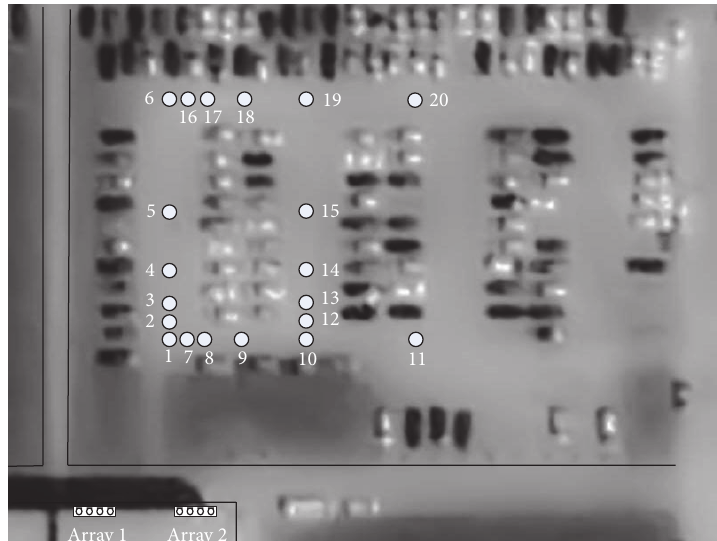
Figure 8: Map of the study area indicating the position of arrays (Array 1 and Array 2) and sources (the twenty labeling numbers: 1, 2, .. ., 20 ).